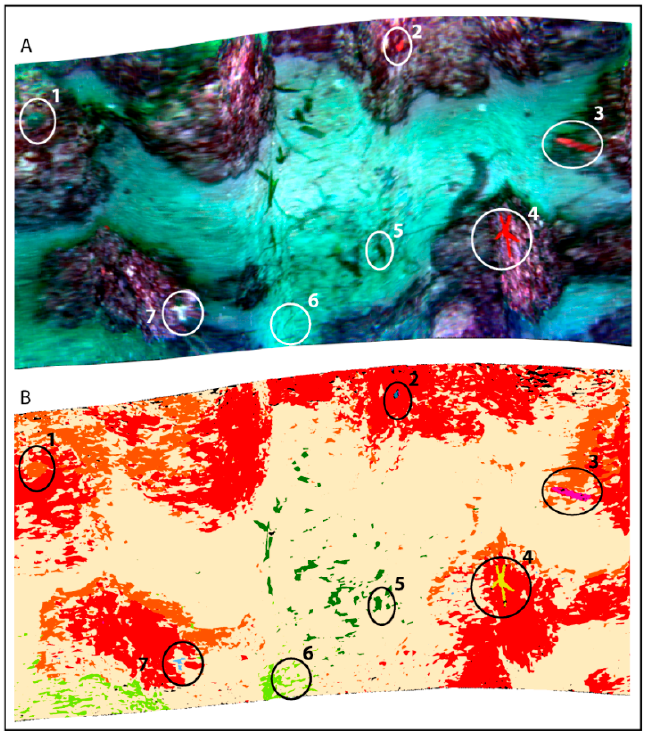
Figure 6. Zoom in the classified segment of coralligenous site, where numbers indicate the organism identified ( A ) and classified ( B ): 1. C. bursa , 2. H. papillosa , 3. Axinella sp. 1, 4. E. sepositus , 5. C. prolifera , 6. P. oceanica , 7. Serpulids. For the colour legend in B, see Figure 5.